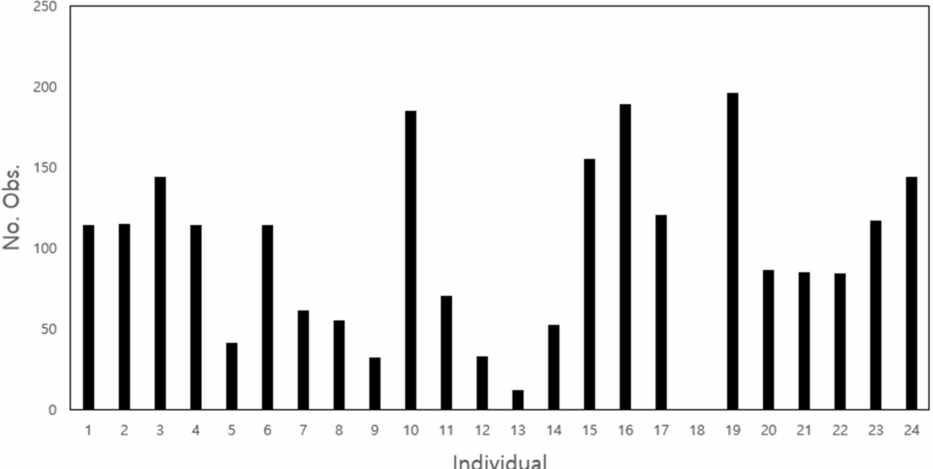
Figure A1. Total number of recordings per individual ( top panel ) and information collected during the survey on the observed individuals ( bottom panel ) in the Macdo